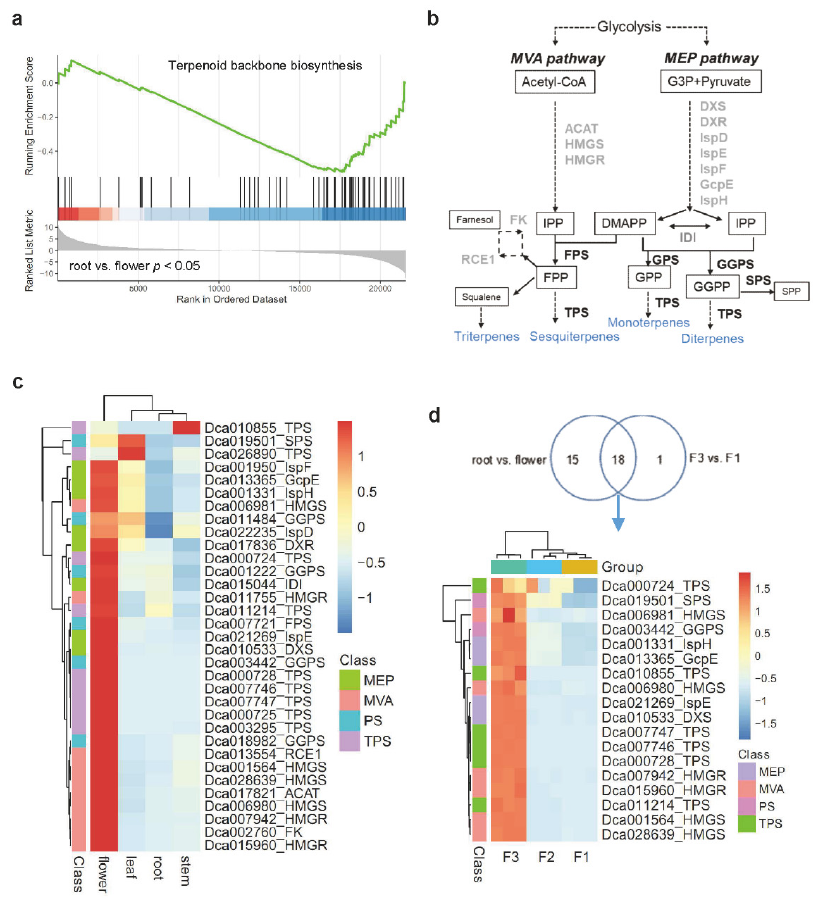
Figure 2. Enrichment analysis of terpene biosynthesis pathway in D . catenatum growth. ( a ) GSEA for root vs. flower comparison. Enrichment scores reveal the expression levels of enriched genes. p